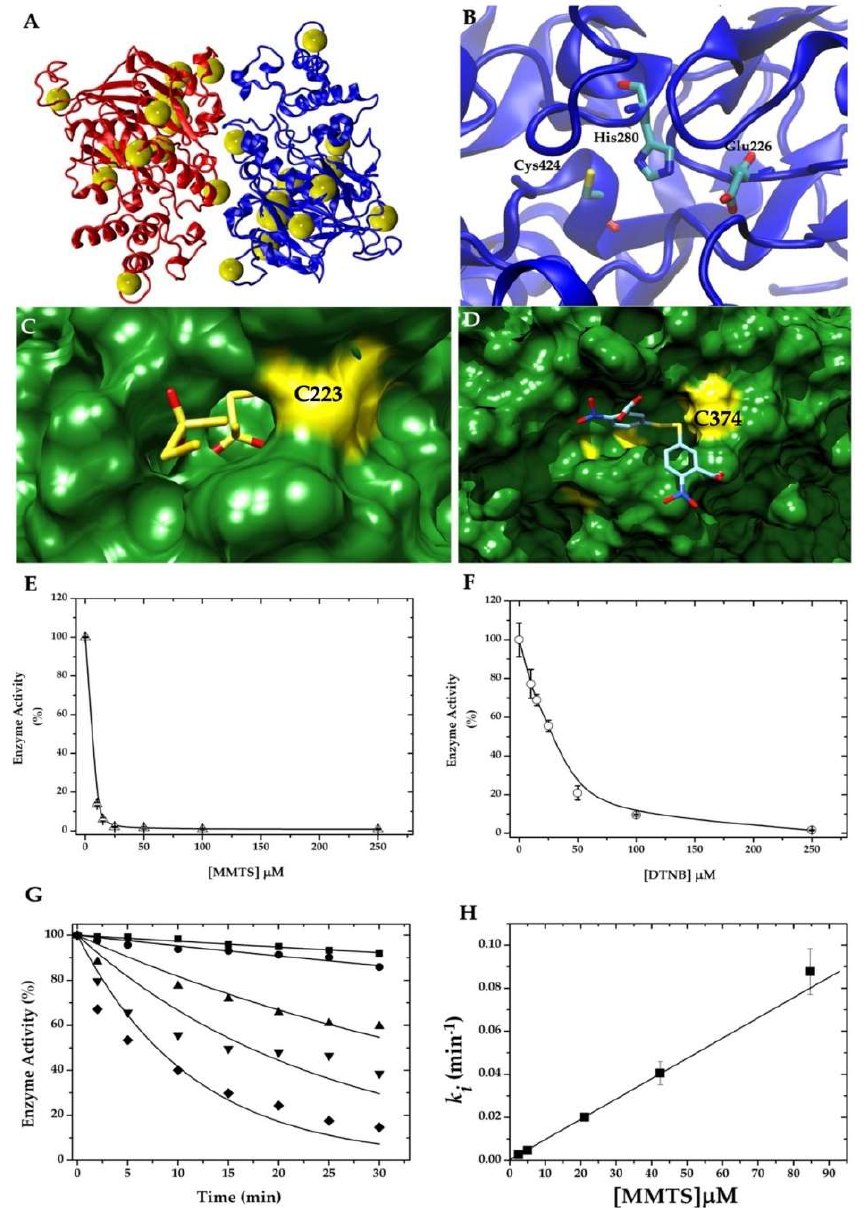
Figure 1. Arginine deiminase from Giardia as a potential target for cysteine reactive compounds. ( A ) Homology model showing the high content and distribution of cysteine residues (yellow spheres). ( B ) active site showing the catalytic triad. ( C ) representative docking with MMTS, and ( D ) with DTNB. Cysteine residues interacting with both molecules are indicated in bold type. Residual enzyme activity of recombinant GlADI after incubation with increasing concentrations of ( E ) MMTS or ( F ) DTNB. ( G ) Kinetics of GlADI inhibition by using 2. 5 ( (cid:4) ), 5 ( • ), 20 ( (cid:78) ), 45 ( (cid:72) ), and 85 µ M ( (cid:117) ) of MMTS. Inactivation rate constants at different MMTS concentrations were fitted to a linear equation model, where the slope represents the second−order inactivation rate constant ( H ).